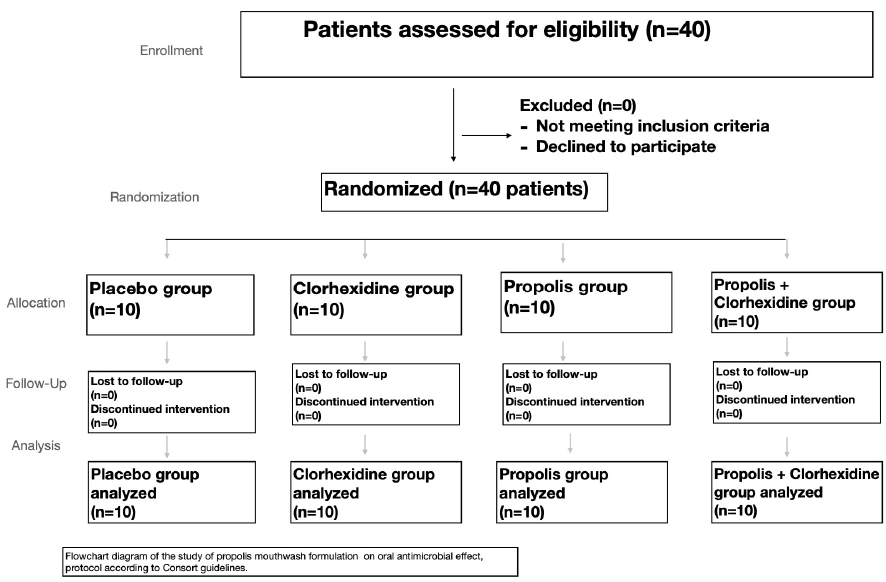
Figure 2. Flowchart of the mouthwash assay. Table 2. Results of different mouthwashes’ formulation on oral antimicrobial